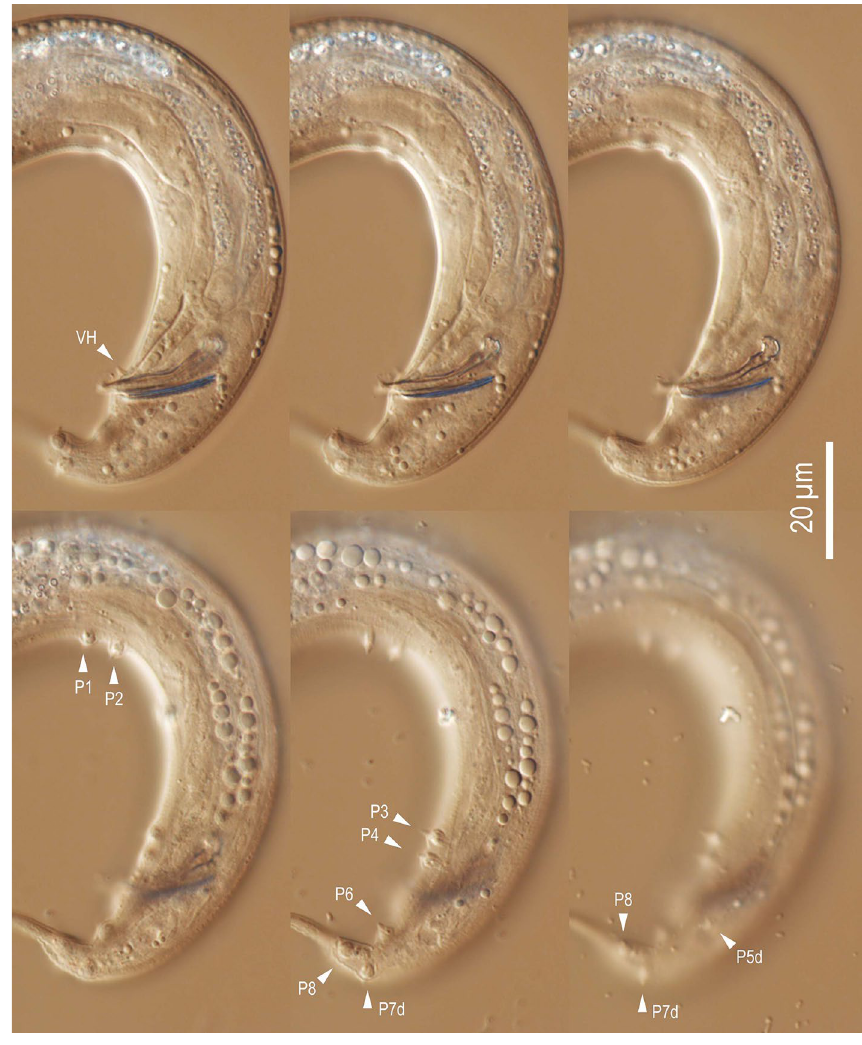
Figure 5. Left lateral view of male tail of Tokorhabditis tufae n. gen., n. sp. in six different focal planes. Abbreviations are as follows: P + number genital papillae where “d” indicates dorsally opened papillae, VH ventral precloacal